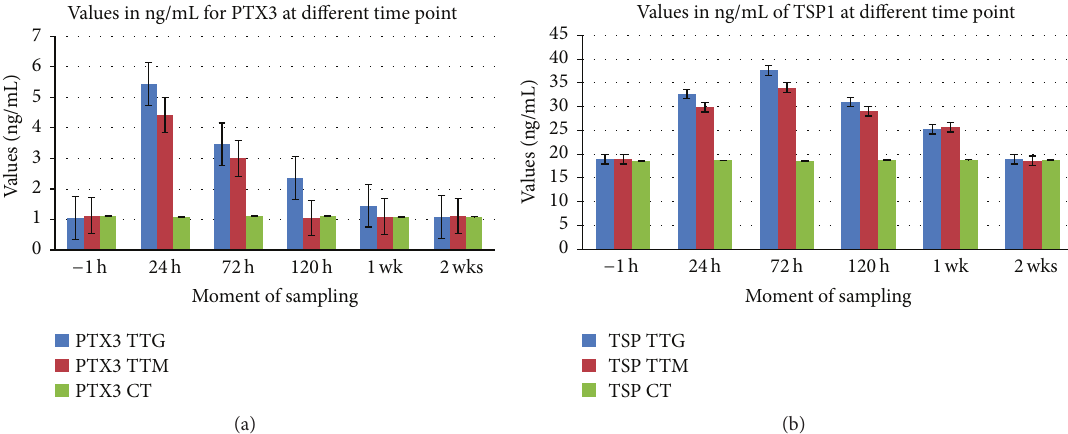
Figure 2: Differences between levels of PTX3 and TSP1 in TTG and TTM. (a) Statistically significant differences between PTX3 at 24, 72, and 120h and baseline in TTG and statistically significant differences between PTX3 at 24 and 72 h and baseline in TTM; (b) statistically significant differences between TSP1 at 24, 72, and 120 h and 1wk and baseline in TTG and statistically significant differences between TSP1 at 24, 72, and 120h and 1wk and baseline in